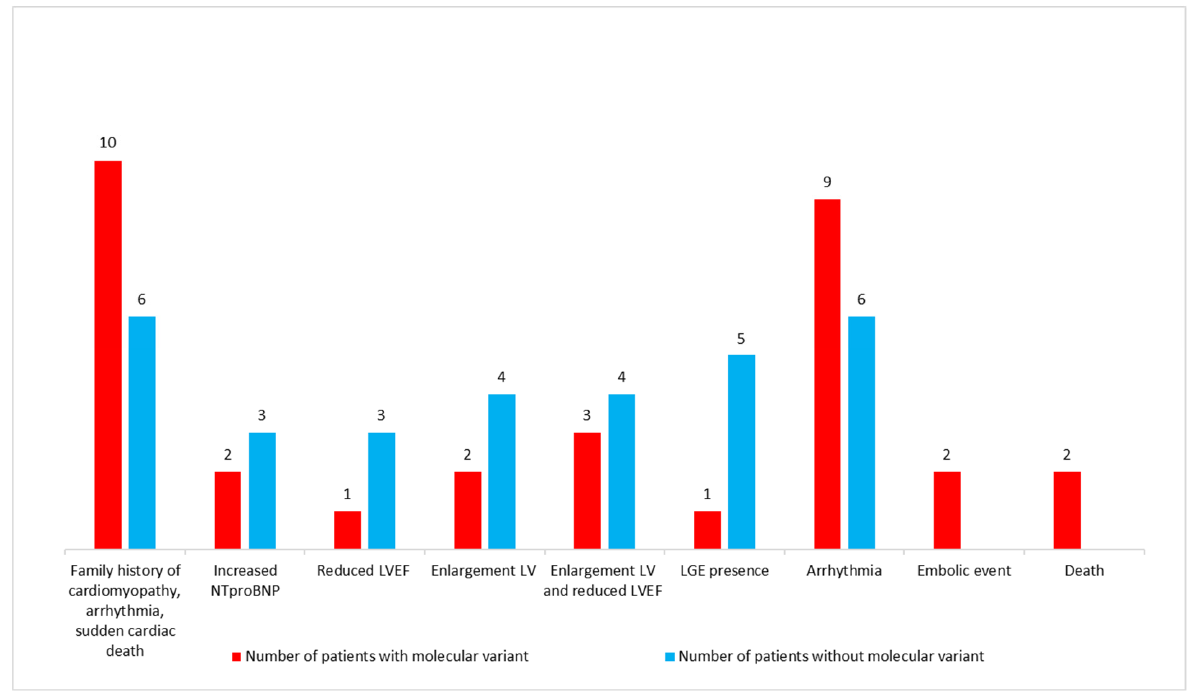
Figure 1. Comparison of clinical data in patients with/without molecular